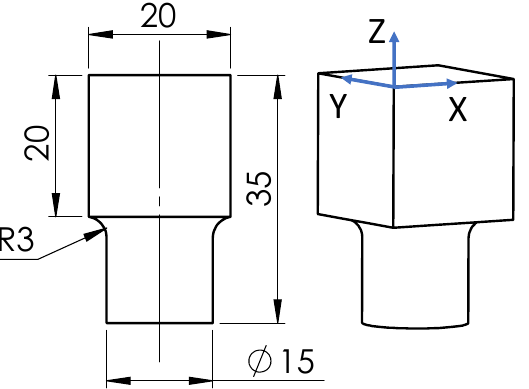
Figure 1. Design of the parts (in